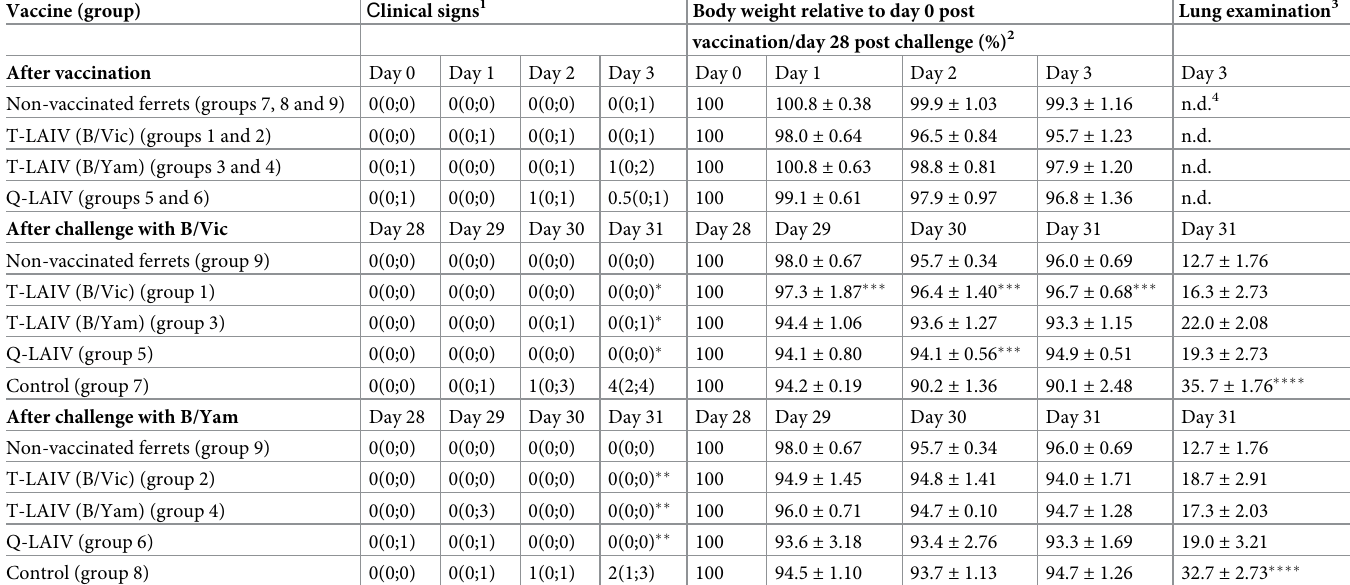
Table 1. Clinical observations in ferrets vaccinated with trivalent or quadrivalent LAIV and challenged with B/Brisbane/60/2008 (B/Vic) or B/Phuket/3073/2013 (B/Yam) wild-type influenza viruses. С linical signs 1